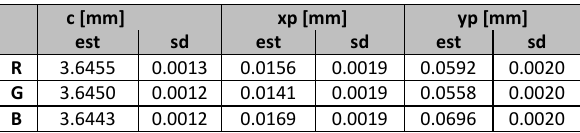
Table 6. Calibration parameters (c, xp, yp) for the